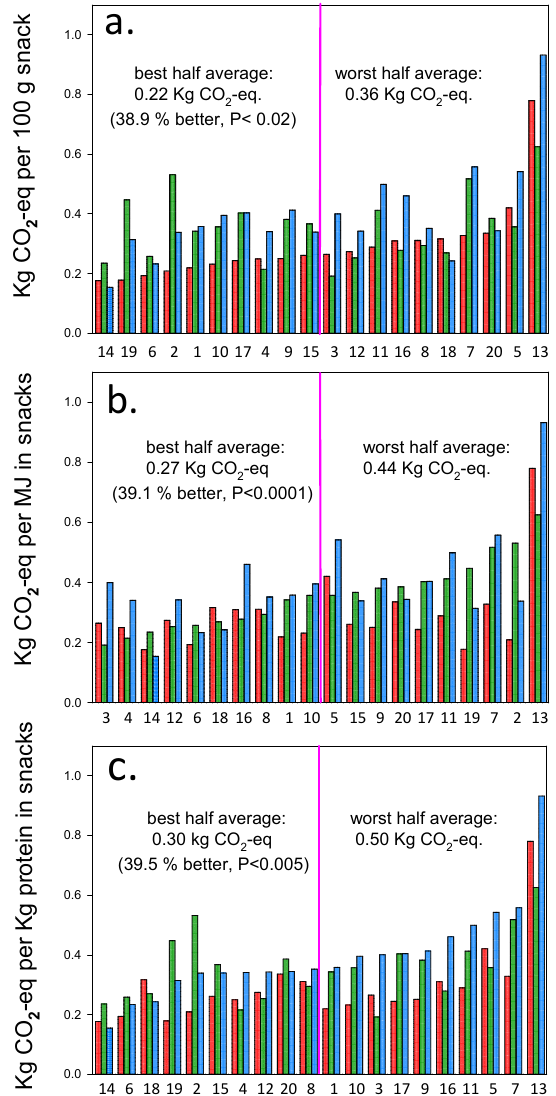
Figure 2. Global warming impact of 20 protein and energy fortified texture modified snacks. The numbers below each set of three bars refer to alphabetically ordered recipe numbers in Figure 1. The first bar (red) in each set indicates impact per 100 g snack, the second (green) impact per MJ energy content, and the third bar (blue) in each set indicates impact per kg protein in the snacks. Top figure ( a ) arranged by increasing impact relative to weight; middle figure ( b ) arranged by increasing energy content; bottom figure ( c ) arranged by increasing protein content. The average of the best and worst half in terms of climate impact is given in the figure together with the relative difference and associated significance level ( t